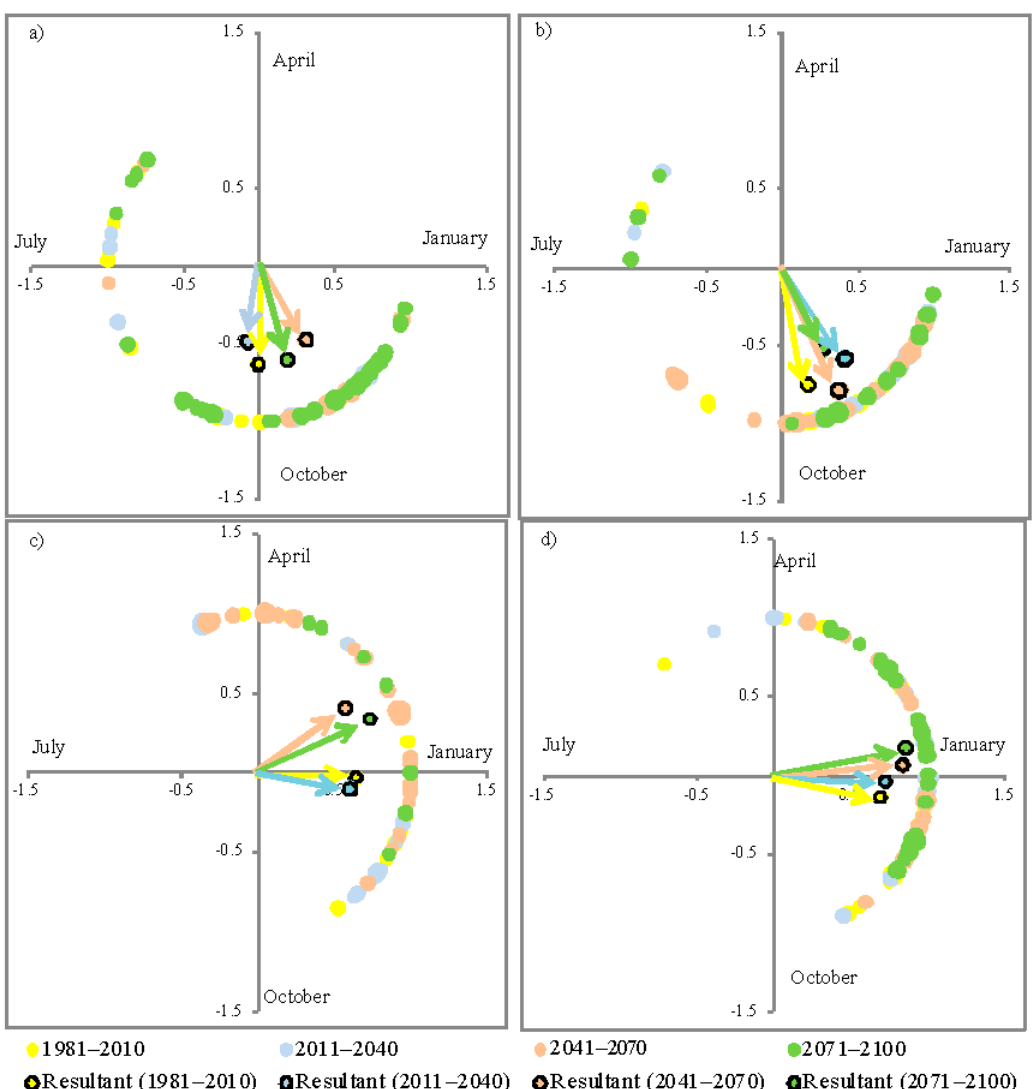
Figure 3. Examples of the seasonality investigation for different global/regional climate models (GCM/RCM) models showing all ROS floods (circles) and resultants (i.e., average values) indicated with arrows of different colors for different periods. ( a ) So č a River for Case 1, ( b ) So č a River for Case 2, ( c ) Gradaš č ica River for Case 3, ( d ) Gradaš č ica River for Case 4.